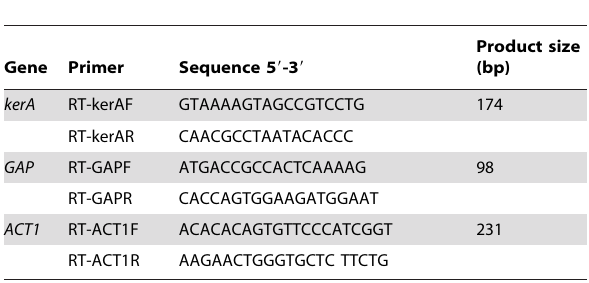
Table 2. Primer sequences for quantitative real-time PCR.